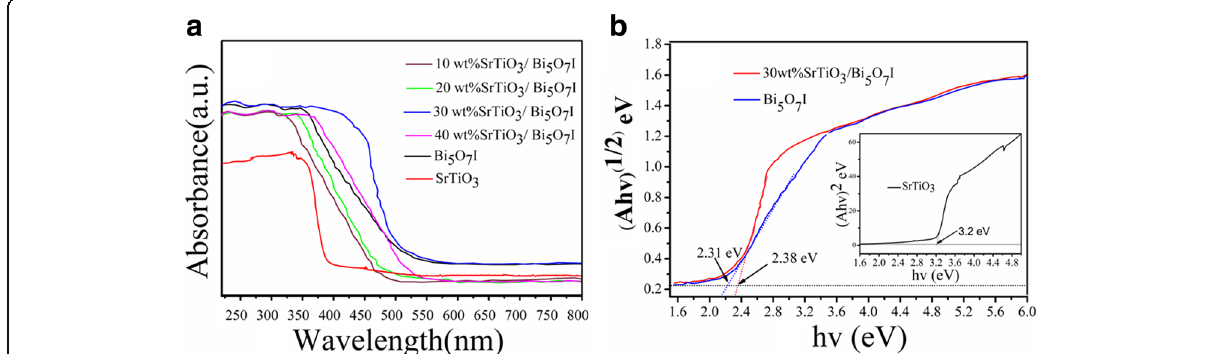
Fig. 4 a DRS spectra of SrTiO 3 /Bi 5 O 7 I nanocomposites and b the Tauc plot of (Ah ν ) 1/2 versus h ν the pure Bi 5 O 7 I and 30 wt% SrTiO 3 /Bi 5 O 7 I nanocomposite, the Tauc plot of (Ah ν ) 2 versus h ν the pure SrTiO 3 inset picture of